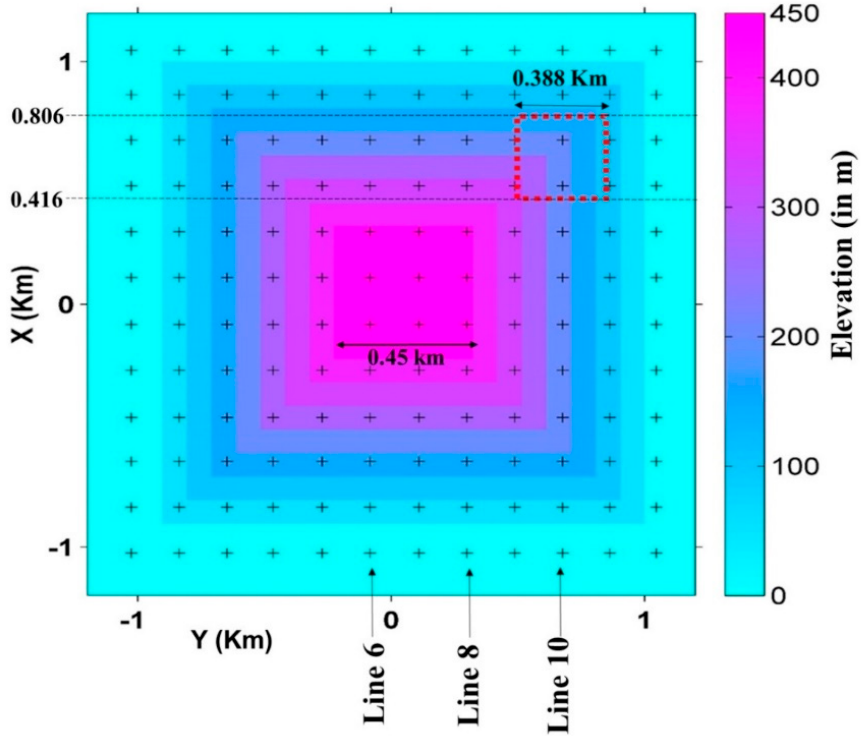
Figure 1. The topographic map of trapezoidal hill model (based on [22]) with an anomalous body (red dashed square). There are 144 number of sites in 12-profile spread all over the hill.